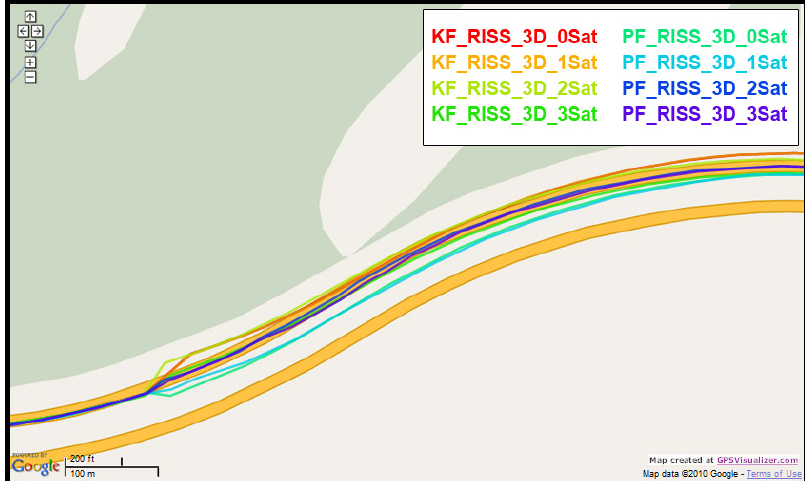
Figure 6. Performance towards the end of the simulated GPS outage #5 of the first